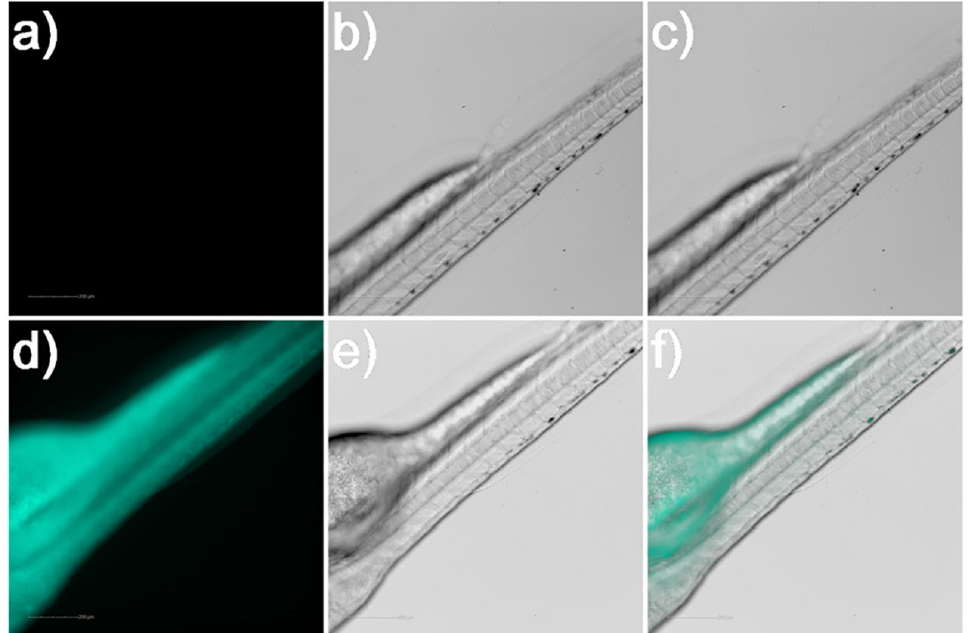
Figure 6. Fluorescence ( a , d ), Bright field ( b , e ) and merged ( c , f ) images of zebrafish. Top row ( a – c ): only seeded with probe 61 for 30 min. Bottom row, ( d – f ): pre − trained with SO 32 − for 30 min and then seeded with probe 61 for 30 min.